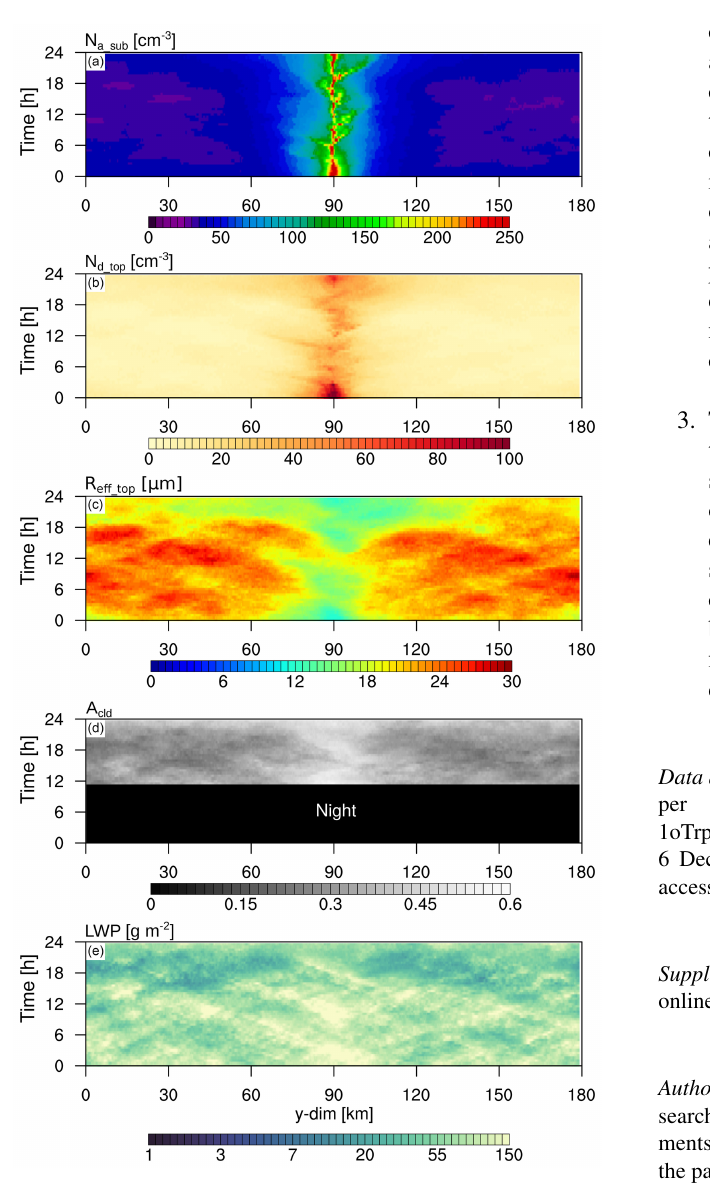
Figure 6. Hovmoeller diagrams of (a) sub-cloud layer mean aerosol concentration ( N a_sub ), (b) cloud-top cloud droplet number con- centration ( N d_top ), (c) cloud-top mean effective cloud droplet ra- dius ( R eff_top ), (d) cloud albedo ( A cld ) and (e) liquid water path (LWP). Spatial averages were obtained along the emission line di- mension (coinciding with x dimension of simulation domain). Hov- moeller diagrams for the ctrl simulation are shown in the Supple- ment (Fig.